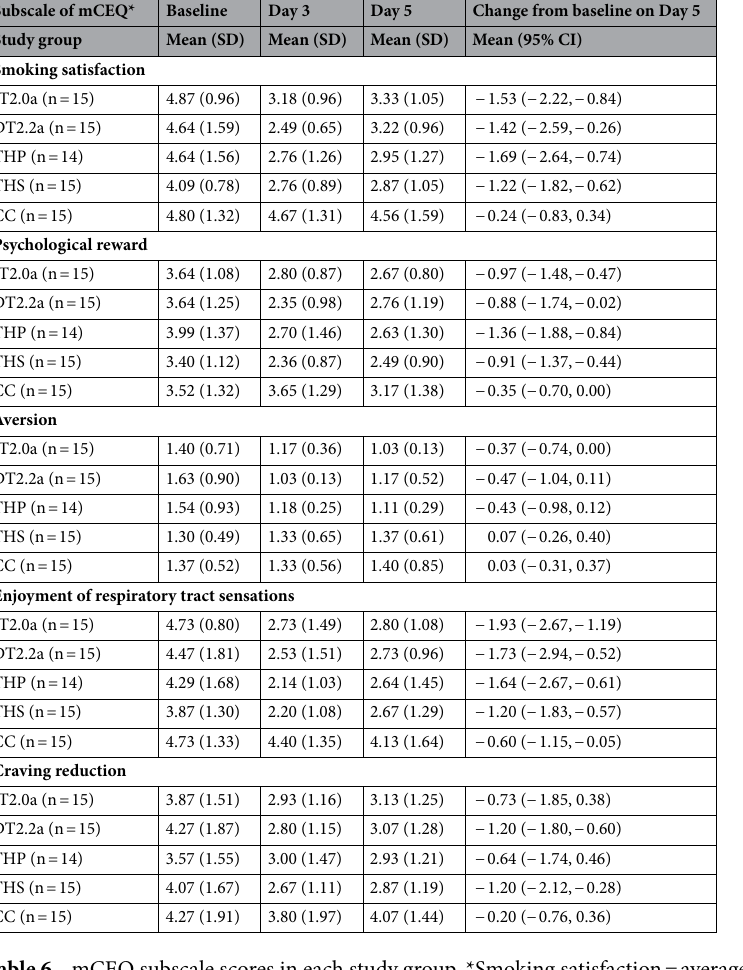
Table 6. mCEQ subscale scores in each study group. *Smoking satisfaction = average score from 3 questions (“Was smoking satisfying?”, “Did the cigarette taste good?” and “Did you enjoy smoking?”); Psychological reward = average scores from 5 questions (“Did smoking calm you down?”, “Did smoking make you feel more awake?”, “Did smoking make you feel less irritable?”, “Did smoking help you concentrate?”, and “Did smoking reduce your hunger for food?”); Aversion = average score from 2 questions (“Did smoking make you dizzy?” and “Did smoking make you nauseous?”); Enjoyment of respiratory tract sensations = score from a question (“Did you enjoy the sensations in your throat and chest?”); Craving reduction = score from a question (“Did smoking immediately reduce your craving for a cigarette”). Each item was rated on a 7-point Likert scale ranging from 1 (“Not at all”) to 7 (“Extremely”). CC combustible cigarettes group, CI confidential interval, DT2.2a direct tobacco heating system platform 2 generation 2 version a group, IT2.0a indirect tobacco